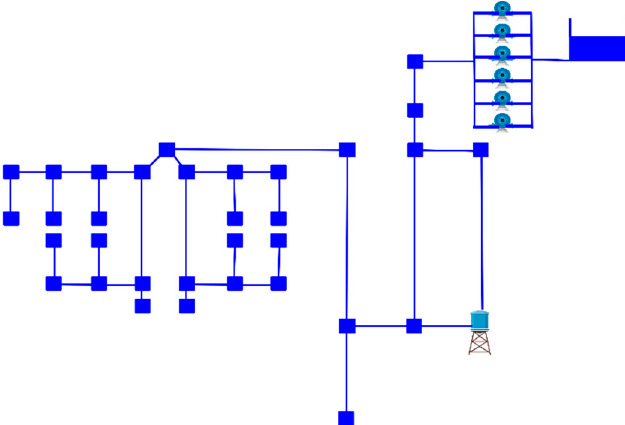
Figure 3. Baghmalek network.